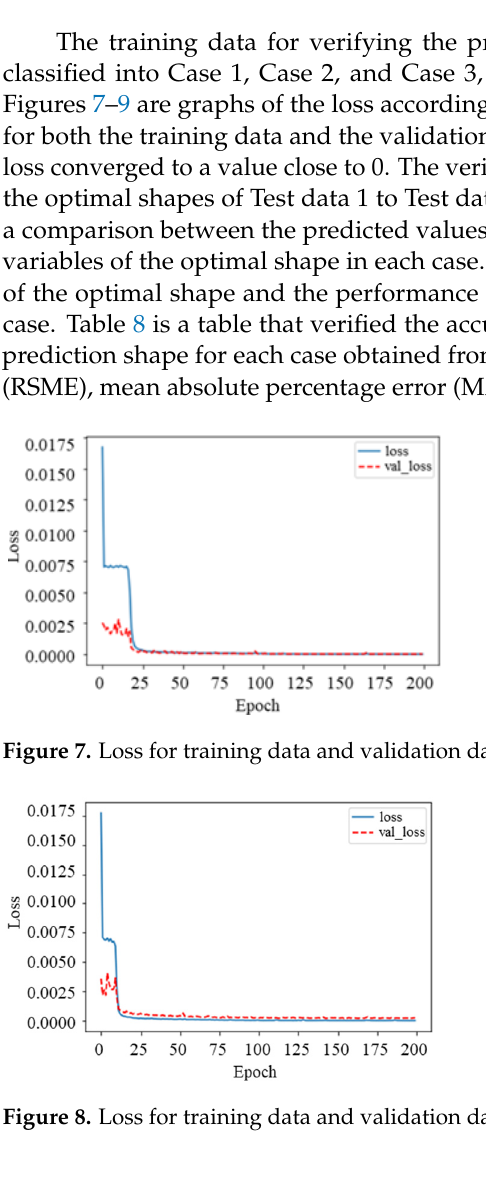
Figure 9. Loss for training data and validation data in Case 3. Table 7. Comparison of results for Type 3-1 optimal and predicted shapes in Cases 1, 2, and 3. Optimal Shape